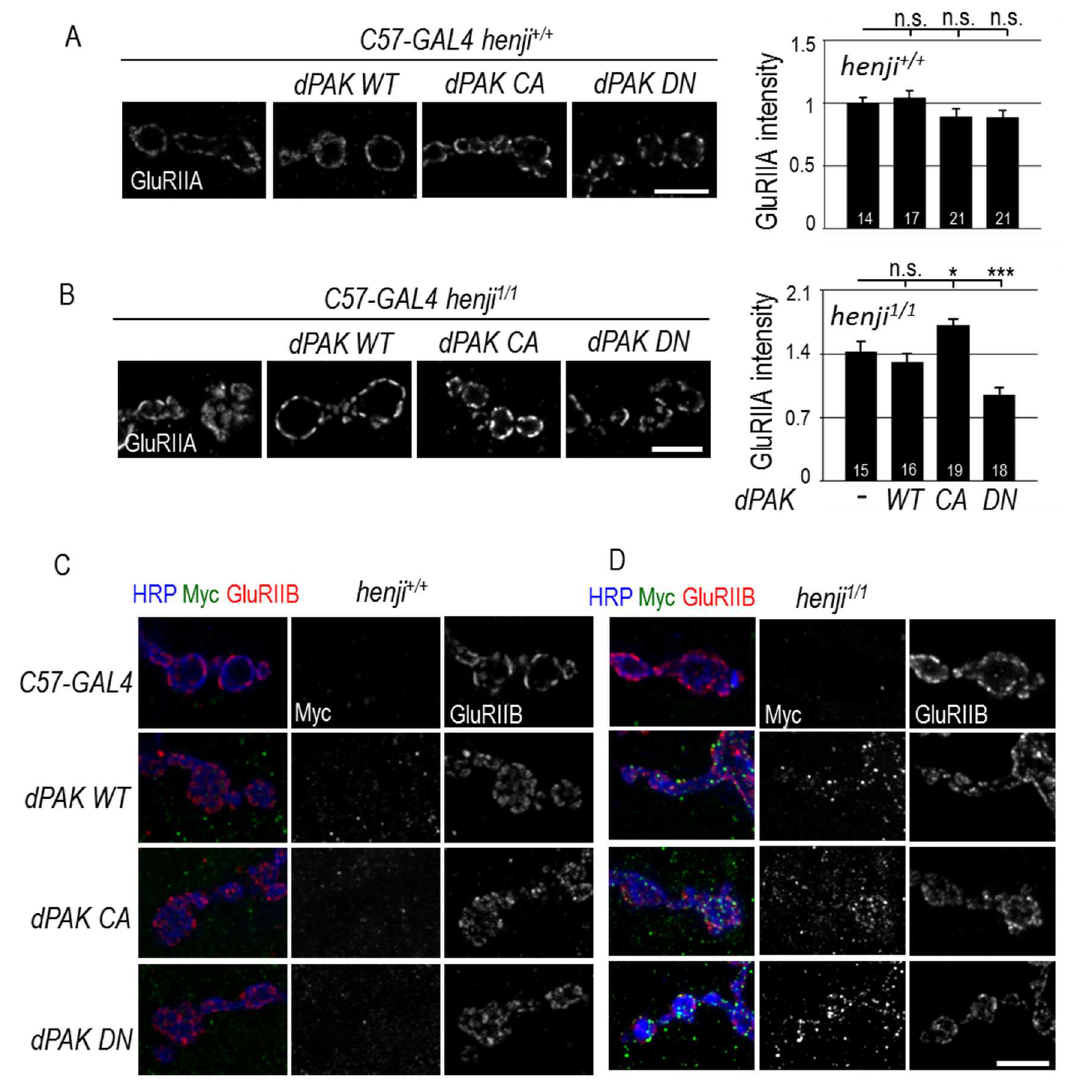
Fig 8. Henji suppresses dPAK activation and localization. (A, B) Overexpression of dPAK of WT , CA and DN transgenes in henji +/+ (A) and henji 1/1 (B) to assess the effects on GluRIIA abundance.Quantifications of GluRIIA intensities normalizedto co-stainedHRP intensity for dPAK overexpression in henji +/+ and henji 1/1 , respectively, are shown in bar graphs (right panels): C57-GAL4 , 1.00 ± 0.04 and 1.43 ± 0.10; C57 > dPAK WT , 1.04 ± 0.06 and 1.31 ± 0.08; C57 > dPAK CA , 0.89 ± 0.06 and 1.72 ± 0.10; C57 > dPAK DN , 0.89 ± 0.06 and 0.95 ± 0.06. No significant differences could be detected among all transgenesfor henji +/+ in comparisonto C57-GAL4 (A, right panel). Statistical significance by unpairedStudent t-test is shown as * for p < 0.05 and *** for p < 0.001 when compared to C57-GAL4 henji 1/1 (B, right panel). (C, D) Immunostaining of NMJs for HRP, Myc and GluRIIB show localizationof Myc-tagged dPAK proteins. GluRIIB serves as the PSD marker. Transgenesof WT, CA, and DN were overexpressed in muscles by C57-GAL4 in henji +/+ (C) and henji 1/1 (D). Scale bars are 5 μ